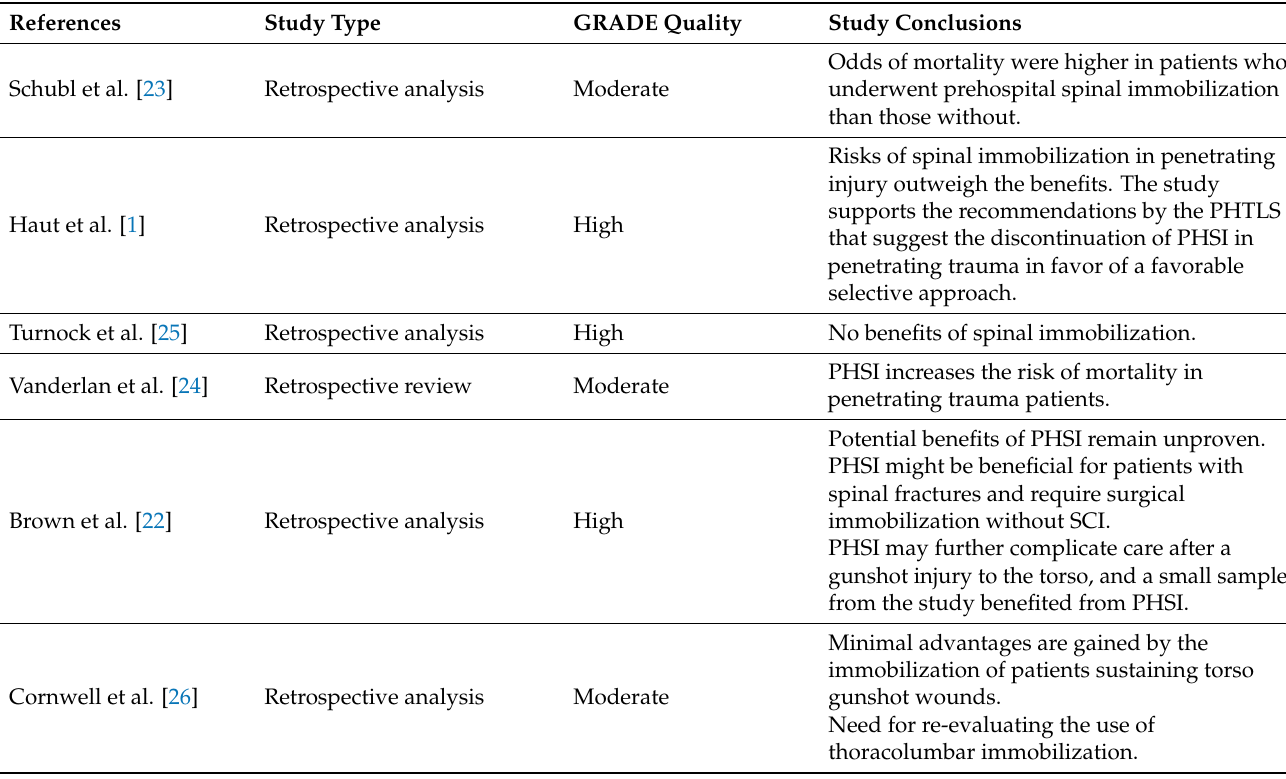
Table 2. GRADE quality and summary of study